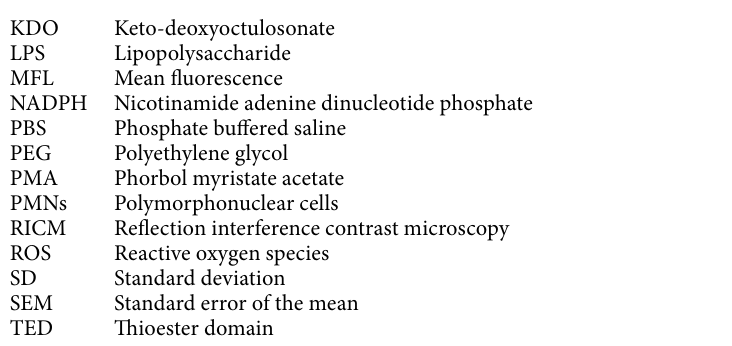
Figure 1. C3b- E. coli directly induce phagocytosis and killing by human neutrophils. ( A ) To produce C3b- E. coli , the thioester of purified C3b was reacted with DBCO-PEG 4 -maleimide to produce C3b-DBCO. Then bacterial LPS decorated with KDO-N3 was reacted with C3b-DBCO to produce C3b- E. coli . ( B ) Flow cytometry histograms displaying the mCherry intensity distribution of engulfed C3b- E. coli in the neutrophil population, for each concentration of C3b-PEG 4 -DBCO. In yellow E. coli was labelled with 2% C6-deficient serum (to prevent MAC formation). ( C ) C3b-DBCO dose-dependent increase of mCherry MFL in neutrophils. Mean ± SEM of 5 independent experiments. ( D ) Representative confocal microscopy image of phagocytosed C3b- E. coli labelled with 190 µg/mL of C3b-DBCO. red = wheat germ agglutinin Alexa-647, (lectin binding β-1,4- N -acetylglucosamine carbohydrate residues on membranes), green = GFP-expressing MG1655. ( E ) Inhibition of the interaction of GFP C3b- E. coli with neutrophils by anti-CR1 (red) and anti-CR3 (blue) blocking antibodies in terms of GFP MFL of internalized C3b- E. coli of the total neutrophil population. Mean ± SEM of 3 independent experiments. ( F ) Chemiluminescence intensity of reactive oxygen species released by neutrophils after incubation with C3b- E. coli MG1655 labelled with increasing concentrations of C3b-DBCO. Stimulation with 2.7 µM phorbol myristate acetate (PMA), a potent non-receptor initiator of endogenous ROS production, included as a benchmark. E. coli opsonized with 2% C6-deficient serum (to prevent MAC formation) was also included as positive control. Measurement expressed as mean area under the curve (AUC) ± standard deviation (SD) of 4 independent experiments. Statistical analysis was done using one-way ANOVA with a Dunnett correction for multiple comparisons and displayed only when significant compared to control “0 µg/mL C3b-DBCO” as * (p ≤ 0.05) and ** (p ≤ 0.01). ( G ) CFU count of bacteria labelled with 0, 50, or 500 µg/mL C3b-DBCO, after co-incubation with (“PMNs”) or without (“No PMNs”) neutrophils. CFU count of unlabelled bacteria (with neither KDO-N 3 nor C3b-DBCO) opsonized with 2% C6-deficient serum (dashed line) is a positive control mimicking the natural deposition of complement. The graph represents the mean of CFU count ± SEM of 3 independent experiments. Statistical analysis was done using a two-way ANOVA with a Dunnett correction for multiple comparisons and displayed only when significant as **(p ≤ 0.01) and ***(p ≤